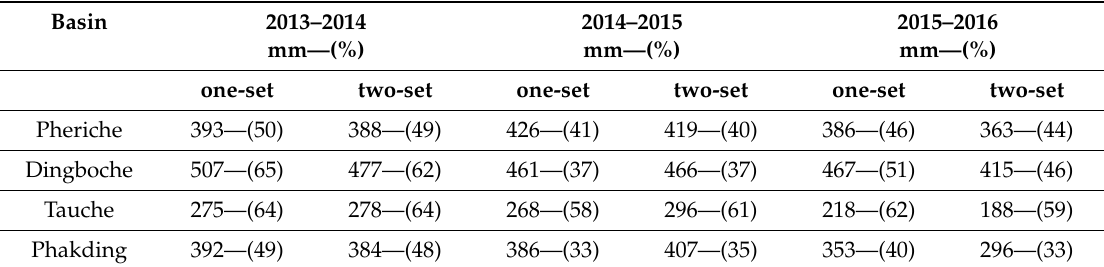
Table 7. Annual volumes of simulated snowmelt using (A) the one-set and (B) the two-set version of the snow model. The percentages are those values divided by the annual observed